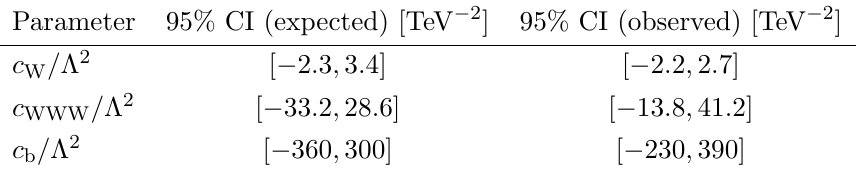
Table 14 . Expected and observed one-dimensional con(cid:12)dence intervals (CI) at 95% con(cid:12)dence level for each of the considered EFT parameters, accounting only for the interference term between the SM amplitude and the BSM one. The one-dimensional intervals for each parameter are computed (cid:12)xing the other two parameters to zero, the SM